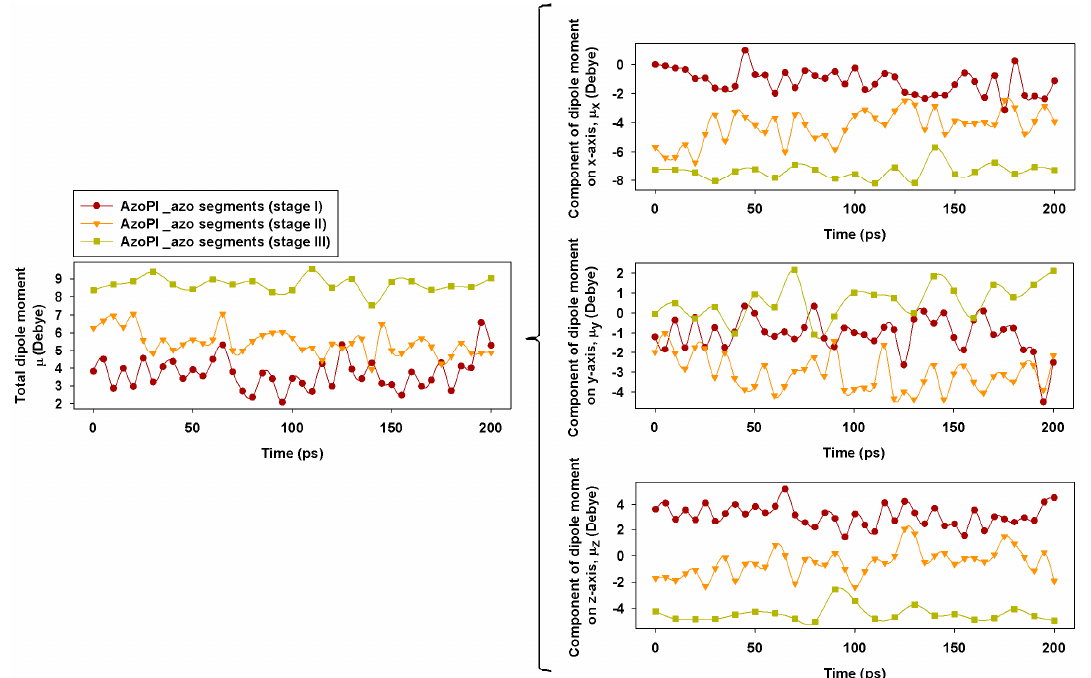
Figure 10. Evolution in time of the mean square displacement function of the AzoPI backbones and corresponding azo segments in stage I, stage II, and stage III.